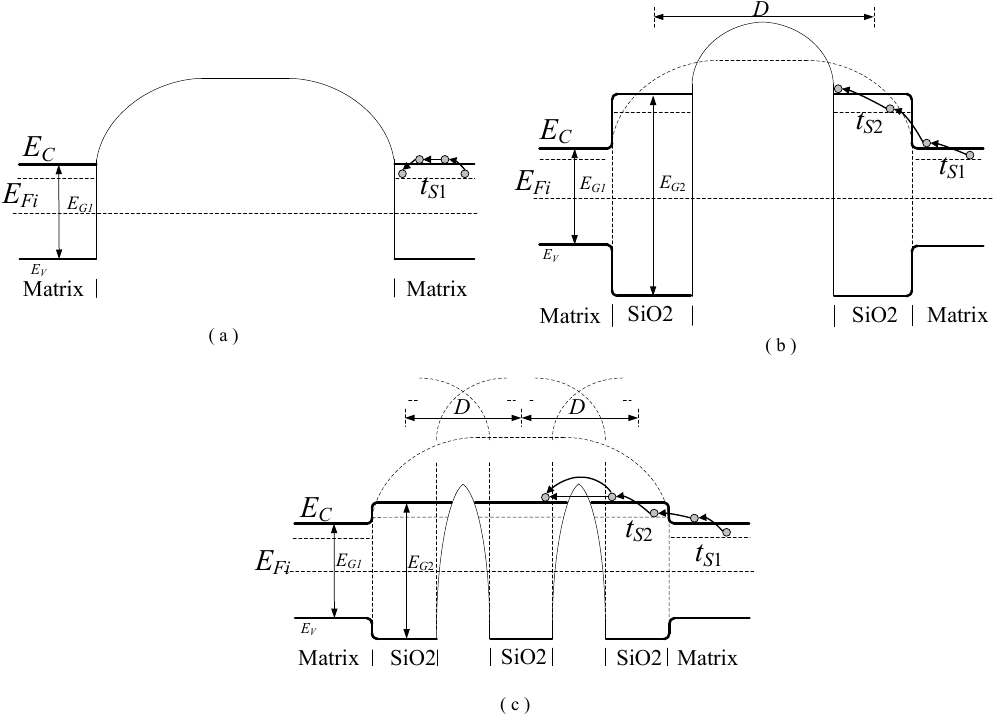
Figure 14. ( a ) band structure of epoxy resin impregnated non-modified pressboard; ( b )Energy band structure of epoxy resin impregnated modified pressboard with low content SiO 2 ; ( c )Energy band structure of epoxy resin impregnated modified pressboard high content SiO 2.